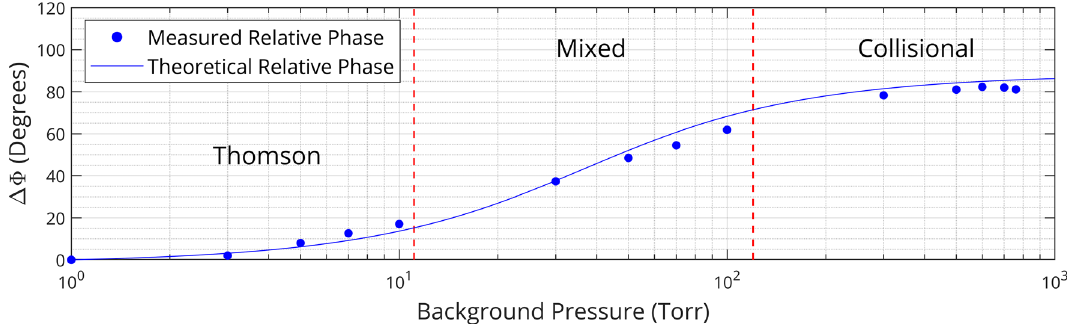
Figure 4. Relative phases for coherent microwave scattering as a function of background pressure. The I/Q- mixer measured relative phase of scattered radiation (cid:31)(cid:30) and theoretical prediction for 11 GHz microwave scattering at t = 3